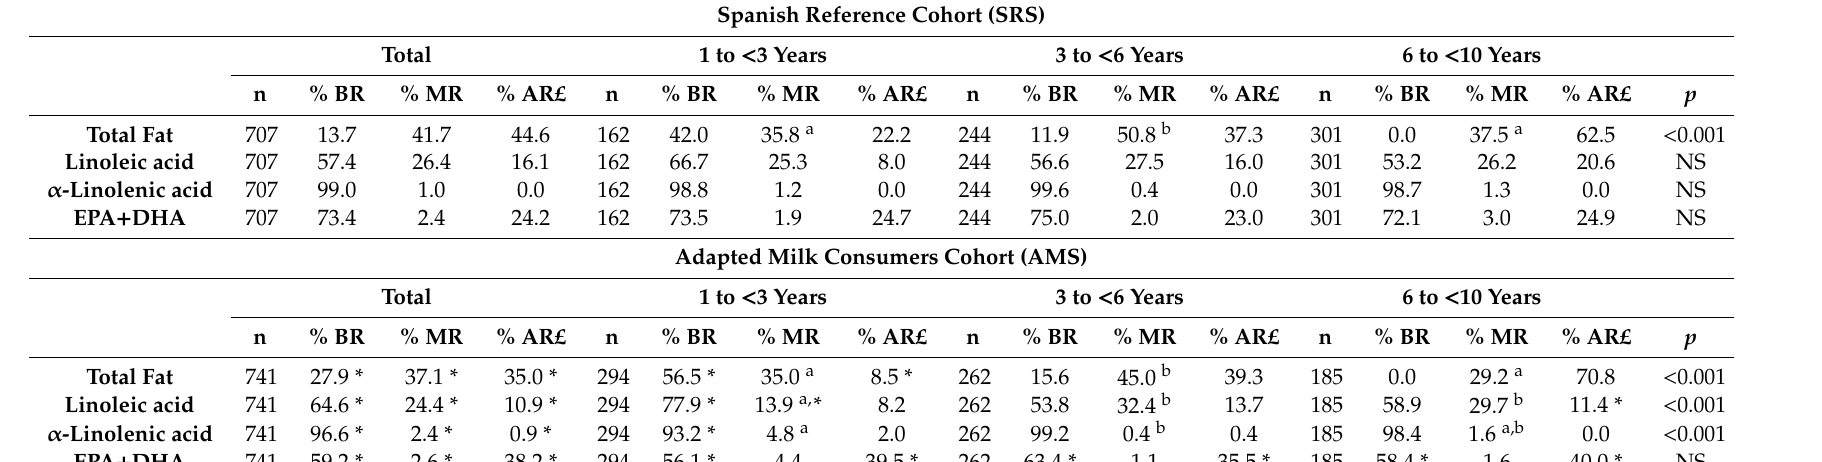
Table 7. Percentages of children meeting and not meeting European Food Safe Authority (EFSA) recommendations for main fatty acids by cohort and age group Figure 1448